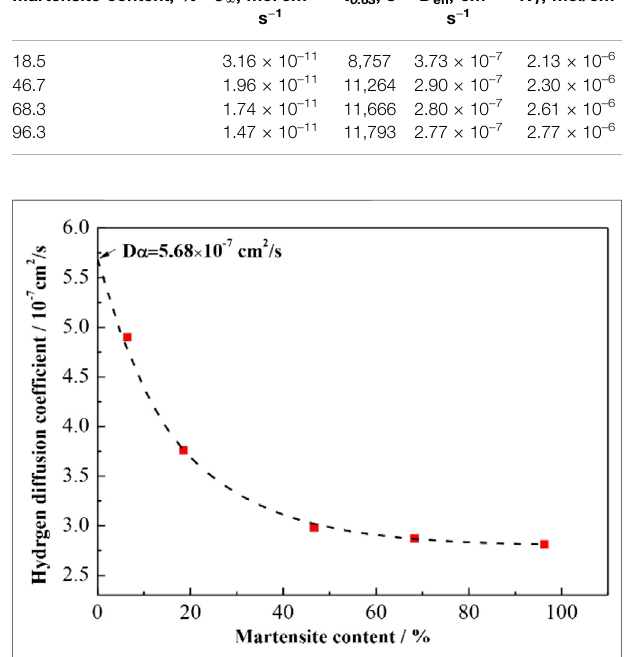
FIGURE 10 | The correlation of the hydrogen diffusion coef fi cient as a function of martensite content in DP steel.